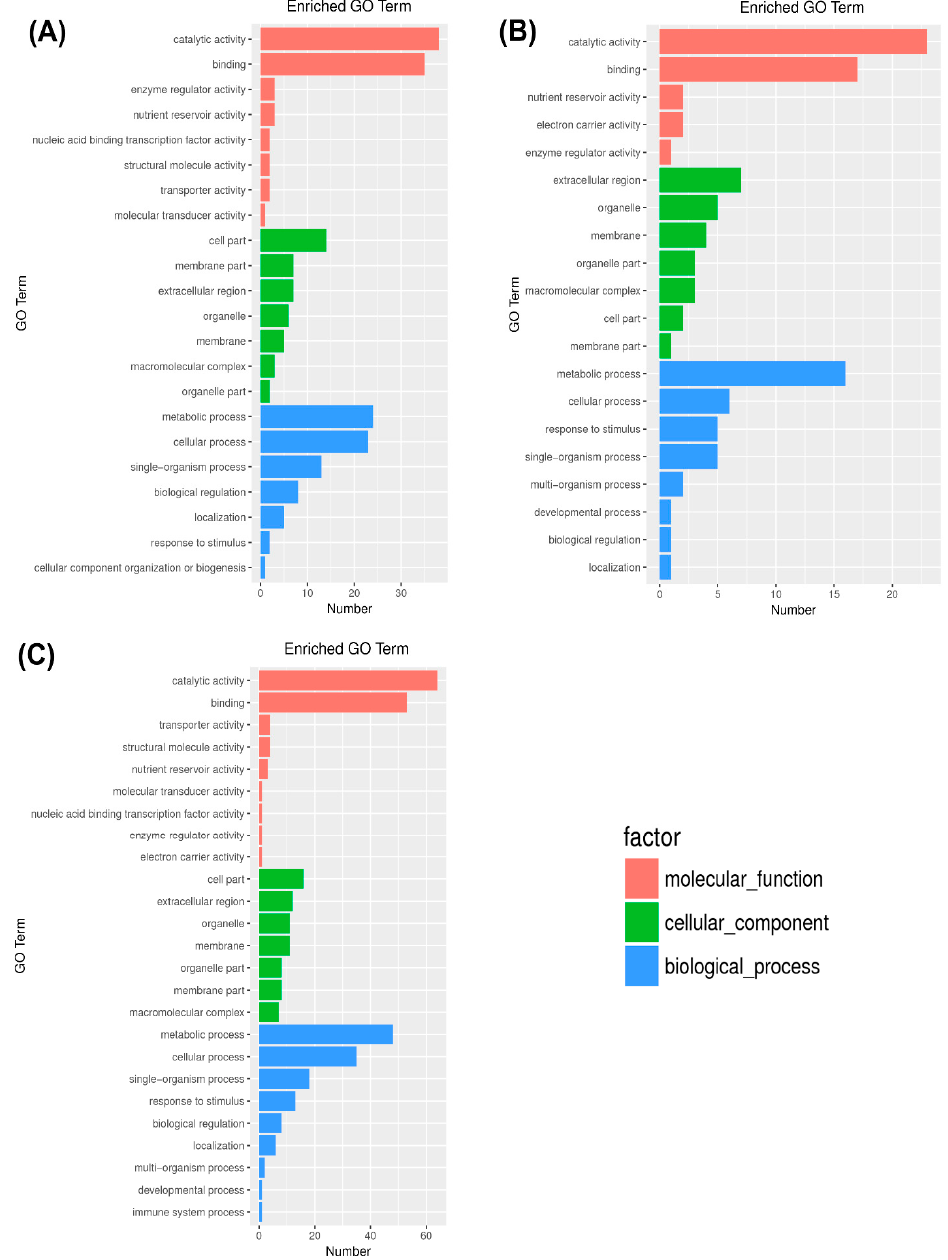
Figure4. GeneontologyenrichmentinallDEGs. Here, ( A )TM-1controlanddrought, ( B )Zhongmian-16 Figure 4. Gene ontology enrichment in all DEGs. Here, ( A ) TM-1 control and drought, ( B ) Zhongmian- control and drought, and ( C ) Pima4-S control and 16 control and drought, and ( C ) Pima4-S control and drought.